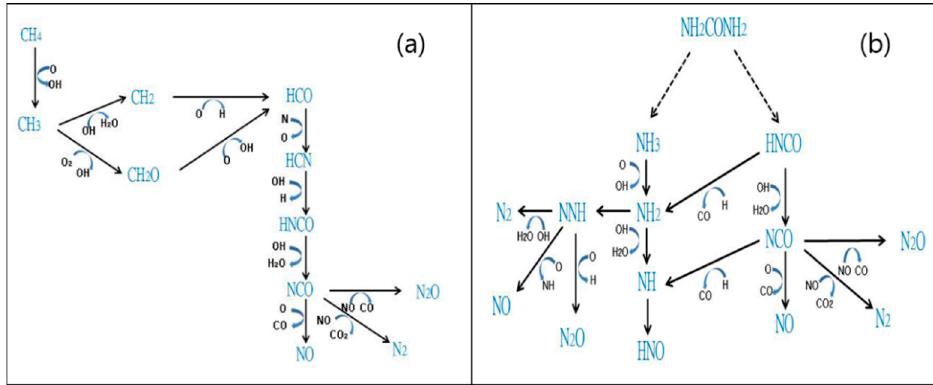
Figure 8. Comparison of ( a ) CH 4 and ( b ) (NH 2 ) 2 CO primary pathways (NO = 900 ppm, NO 2 = 100 ppm, O 2 = 7 vol%, CH 4 NSR = 2, temperature = 900 ◦